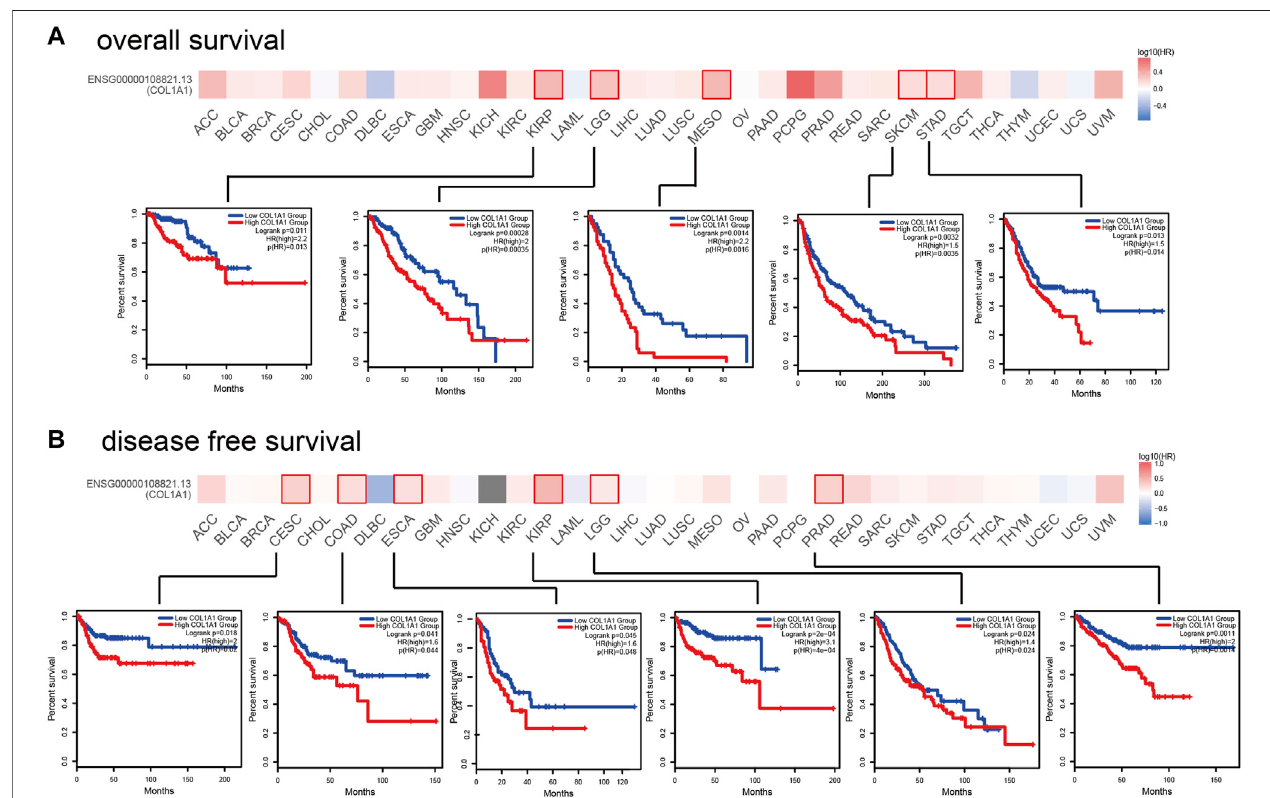
FIGURE 5 | The prognostic impact of COL1A1 in 33 types of human tumors were examined using GEPIA2. (A) High expression of COL1A1 was associated with poor overall survival in KIRP (HR (cid:2) 2.2, p (cid:2) 0.011), LGG (HR (cid:2) 2, p (cid:2) 0.00028), MESO (HR (cid:2) 2.2, p (cid:2) 0.0014), SKCM (HR (cid:2) 1.5, p (cid:2) 0.0032), and STAD (HR (cid:2) 1.5, p (cid:2) 0.013). (B) High expression of COL1A1 was associated with poor disease-free survival in CESC (HR (cid:2) 2, p (cid:2) 0.018), COAD (HR (cid:2) 1.6, p (cid:2) 0.041), ESCA (HR (cid:2) 1.6, p (cid:2) 0.045), KIRP (HR (cid:2) 3.1, p < 0.001), LGG (HR (cid:2) 1.4, p (cid:2) 0.024), and PRAD (HR (cid:2) 2, p (cid:2)